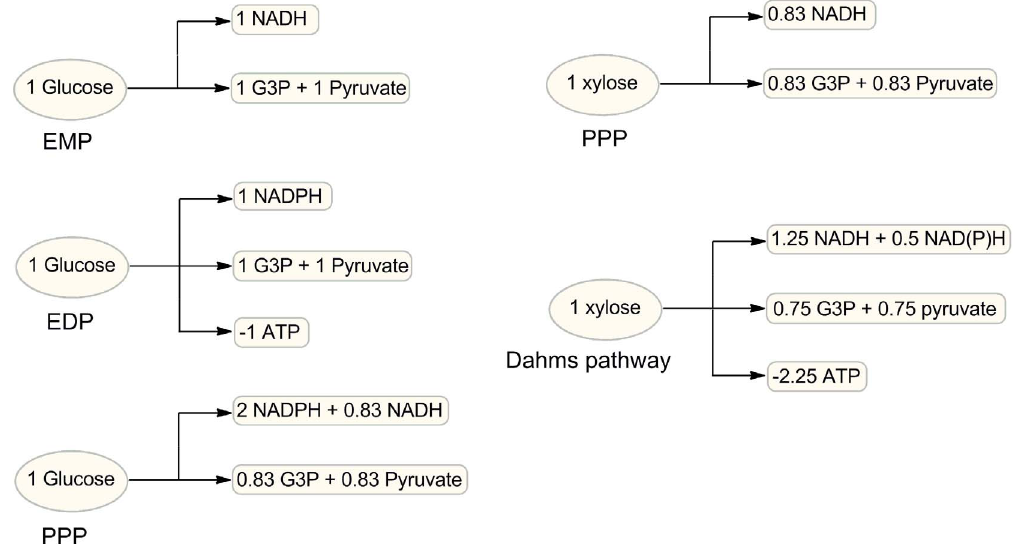
Figure 4. Pyruvate and G3P generation, energy and reducing equivalents production of different glycolytic pathways. doi:10.1371/journal.pone.0083290.g004 PLOS ONE |